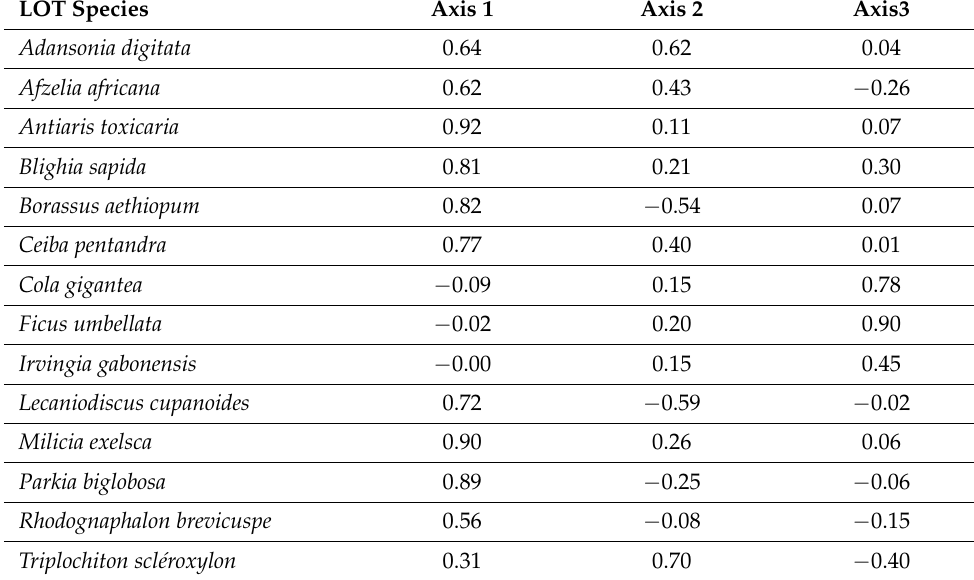
Table 8. Correlation coefficients between principal components and LOTs (PCA). LOT Species